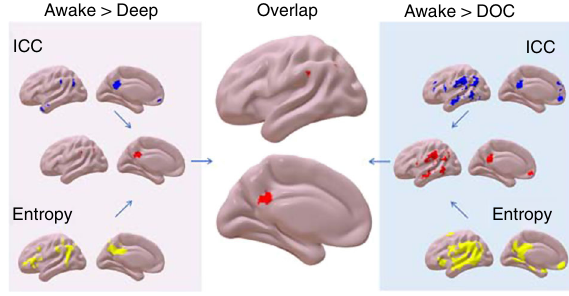
Fig. 1 Brain maps of consciousness-related reductions in intrinsic connectivity contrast (ICC, re fl ecting integrative capacity) and sample entropy (re fl ecting functional diversity over time), and their overlaps between and within datasets. Regions in blue display reduced ICC during unconsciousness (increases are shown in Supplementary Figs. 1 and 2); yellow indicates reduced sample entropy during unconsciousness; and red indicates regions showing both reduced entropy and ICC. Overlaps between anaesthesia (left) and DOC (right) are shown in the middle. Images are shown on medial and lateral surfaces of a smoothed standard Montreal Neurological Institute (MNI-152) structural T1 scan,